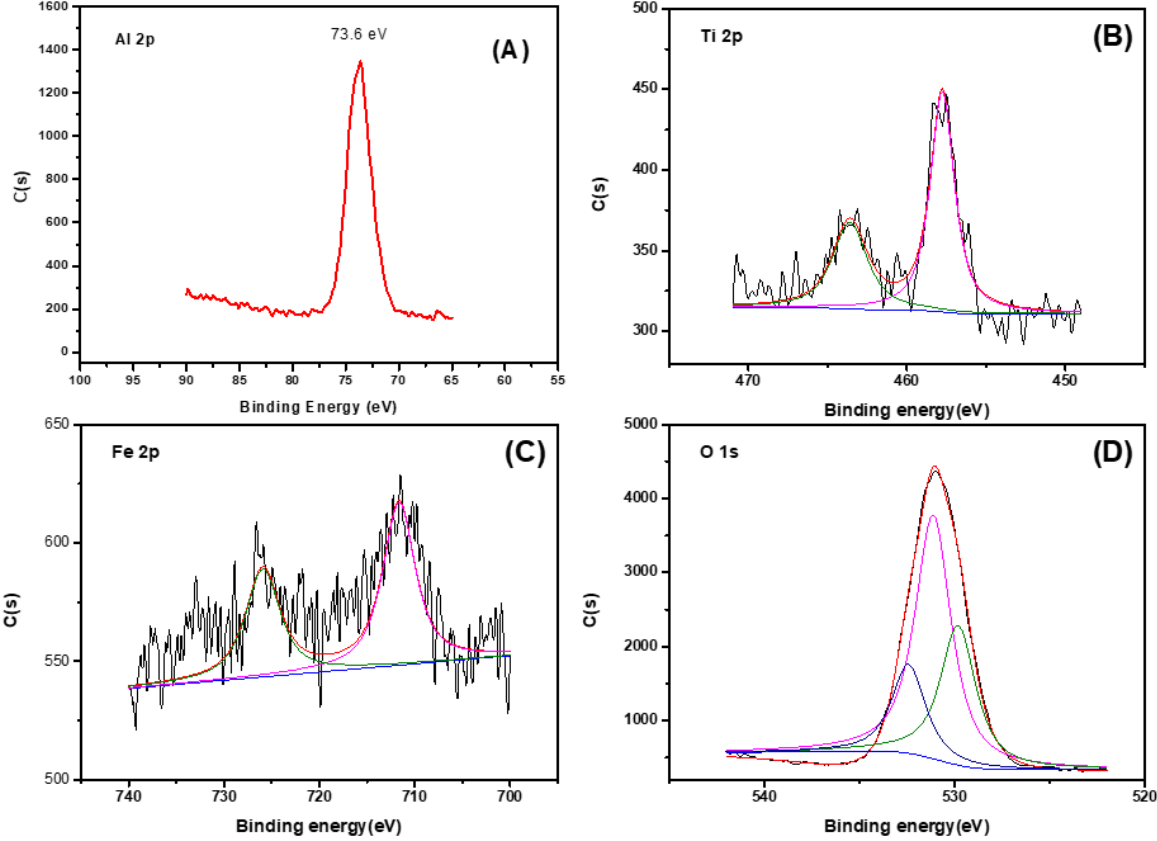
Figure 2. XPS patterns of γ -Al 2 O3/TiO 2 / γ -Fe 2 O 3 : ( A ) Fe 2p; ( B ) Al 2p; ( C ) Fe 2p; ( D ) O 1s.